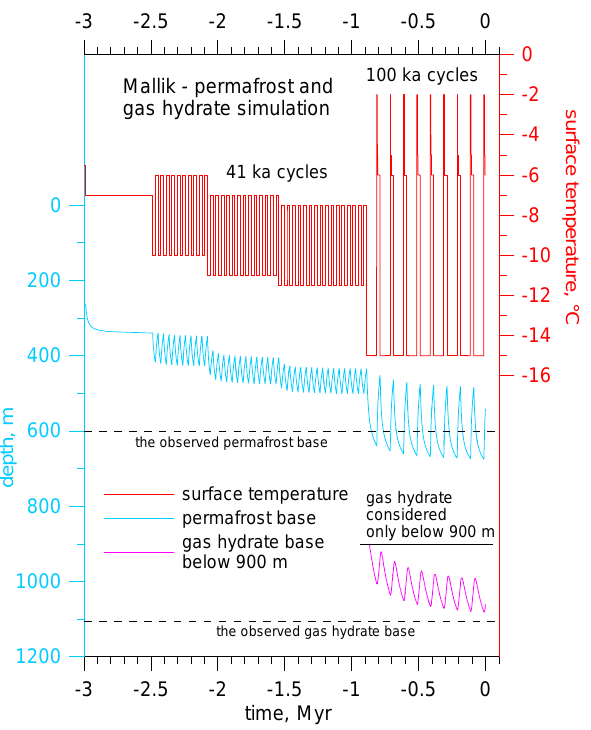
Fig. 4. Case 1 model results illustrating the surface temperature and IBP and GH bases during the last 3Myr according to a numerical simulation of subsurface temperatures for the last 14Myr of surface temperature forcing.